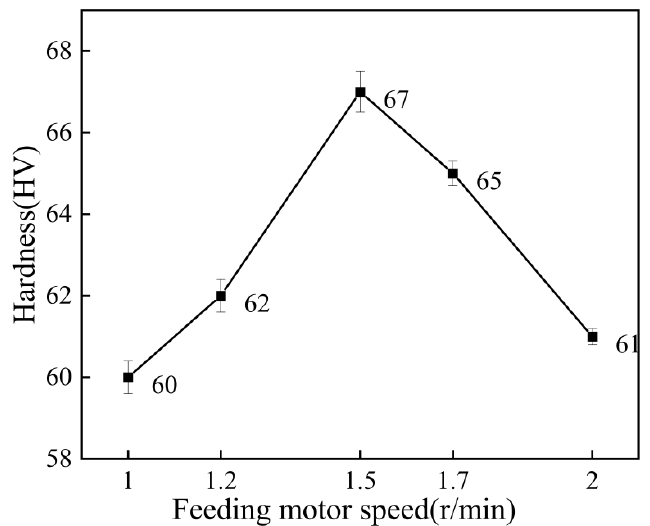
Figure 15. Microhardness of the coating at different feeding motor speeds.